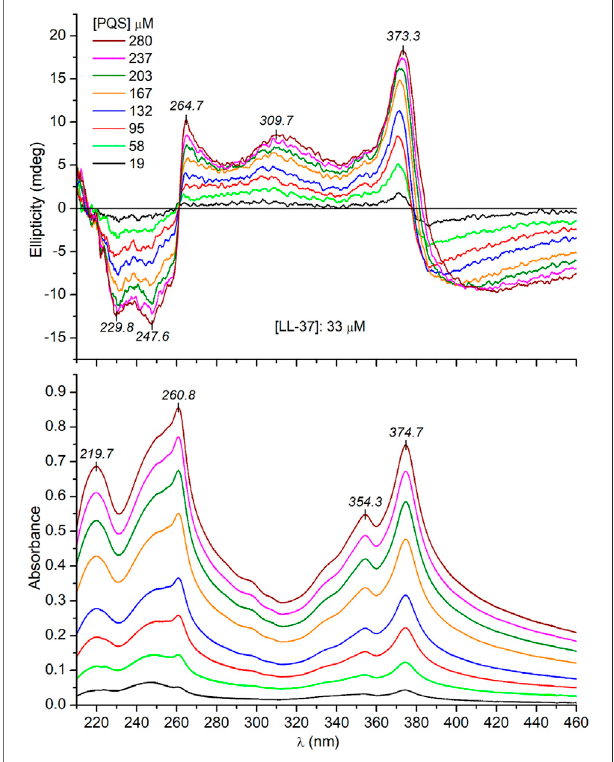
SCHEME 3 | Possible twisted disposition of two J-dimers composed from pairs of PQS molecules. For clarity, the dimers are represented by rectangles. The gray-colored dimer is above the plane of the paper. Double- headed arrows denote the vectorial sum of the corresponding etdms (blue and light blue for 240 nm, red and light red for 340 nm). Chiral exciton couplingbetweendimeretdmsresultsinanegative – positive(left-handed)and a positive – negative (right-handed) CD exciton couplet (red- and blue-colored segments of the experimental CD curve, respectively).